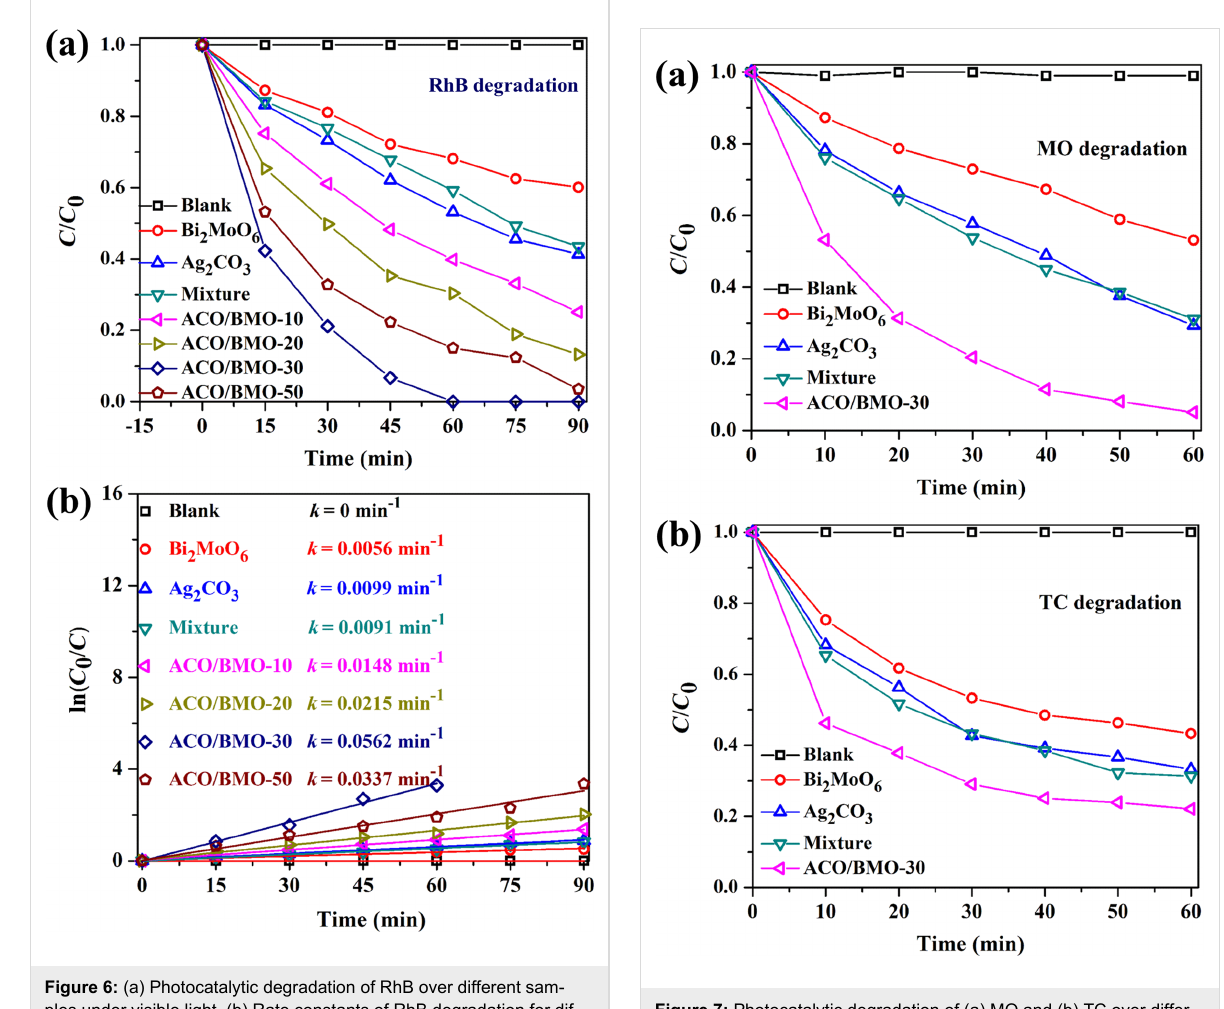
Figure 7: Photocatalytic degradation of (a) MO and (b) TC over differ- ent samples under visible